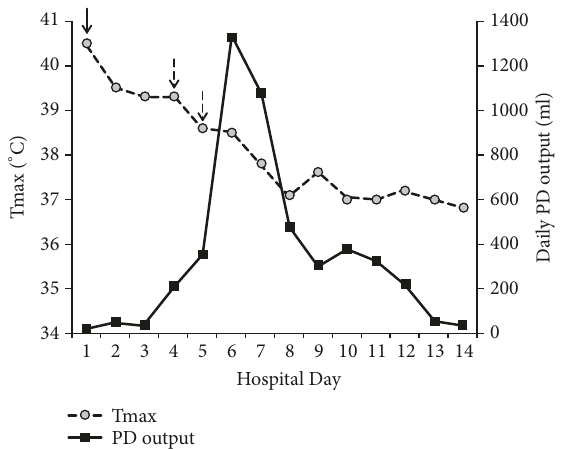
Figure 2: Daily percutaneous drainage (PD) output and maximum temperature (Tmax) during tissue plasminogen activator (tPA) treatment. Solid arrow indicates PD catheter placement and dashed arrows indicate tPA administration days (total of five doses over two